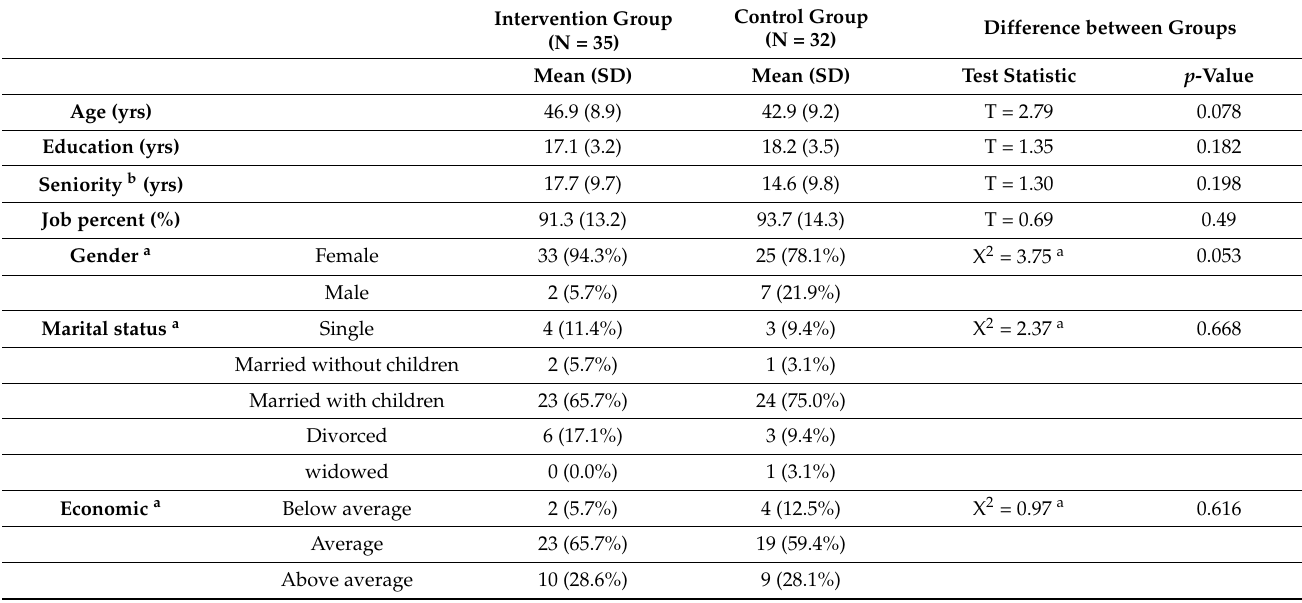
Table 1. Baseline Demographic (N = 67).